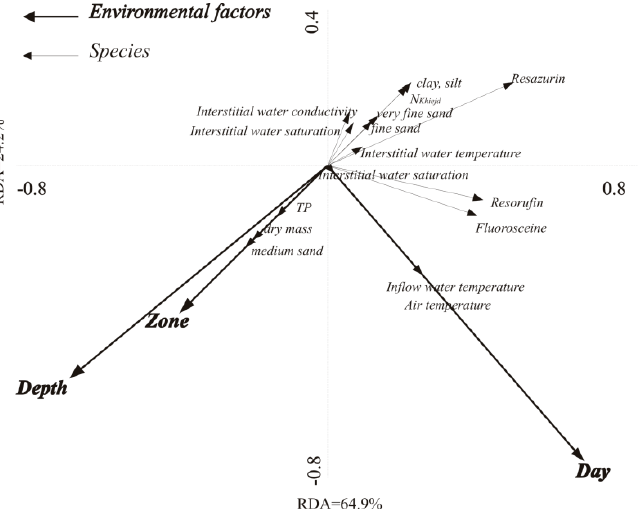
Figure 5. Diagram of RDA to identify the impact of environmental factors on the parameters of